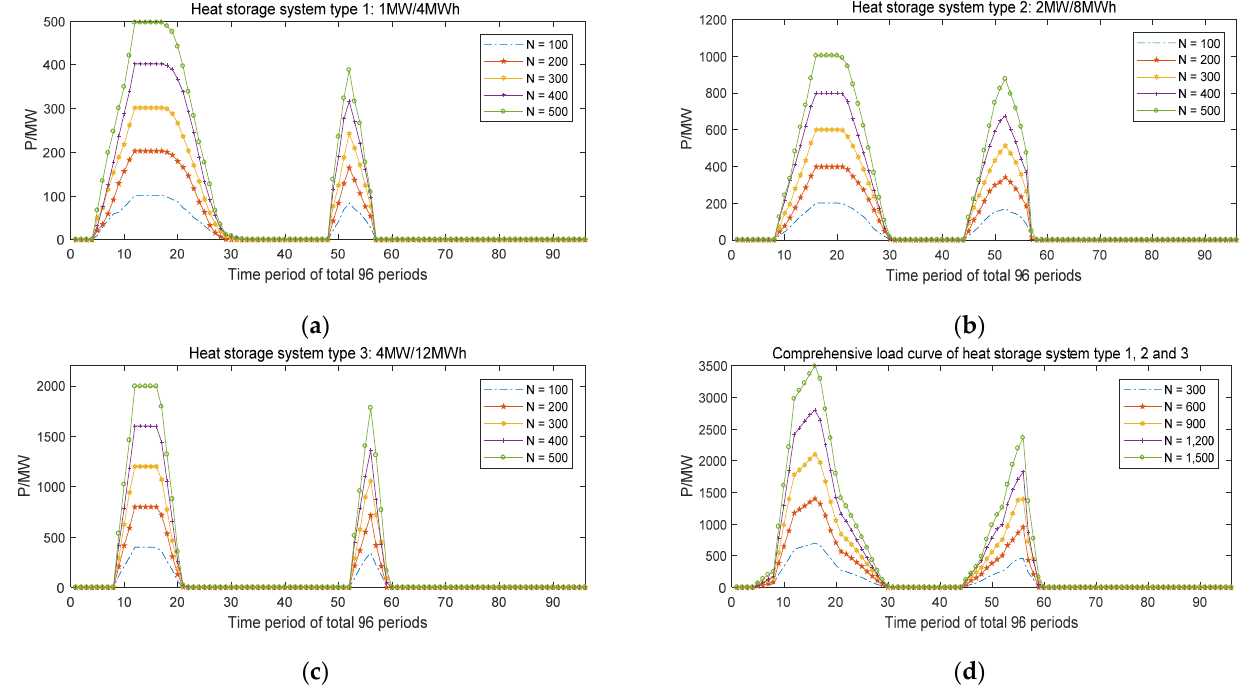
Figure 7. Electrical load curve of a heat storage system: ( a ) curve of a type 1 (1 MW/4 MWh) heat storage device; ( b ) curve of a type 2 (2 MW/8 MWh) heat storage device; ( c ) curve of a type 3 (4 MW/12 MWh) heat storage device; ( d ) comprehensive heat storage load curve of a heat storage device.